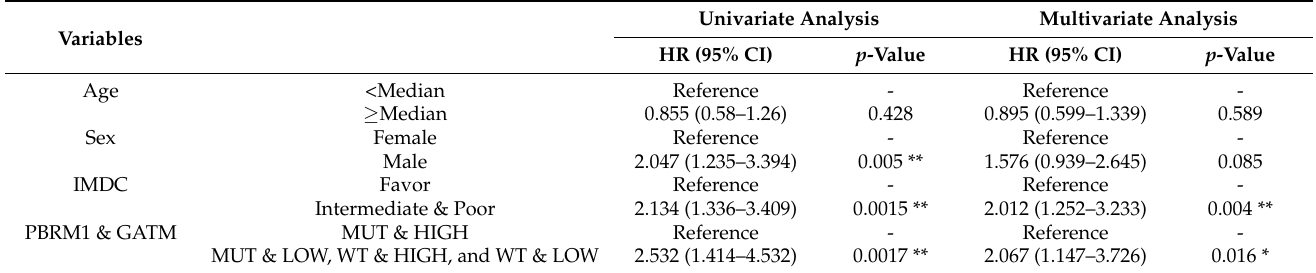
Table 1. Univariate and multivariate analyses for predicting the overall survival of patients with metastatic clear cell renal cell carcinoma treated with immune checkpoint